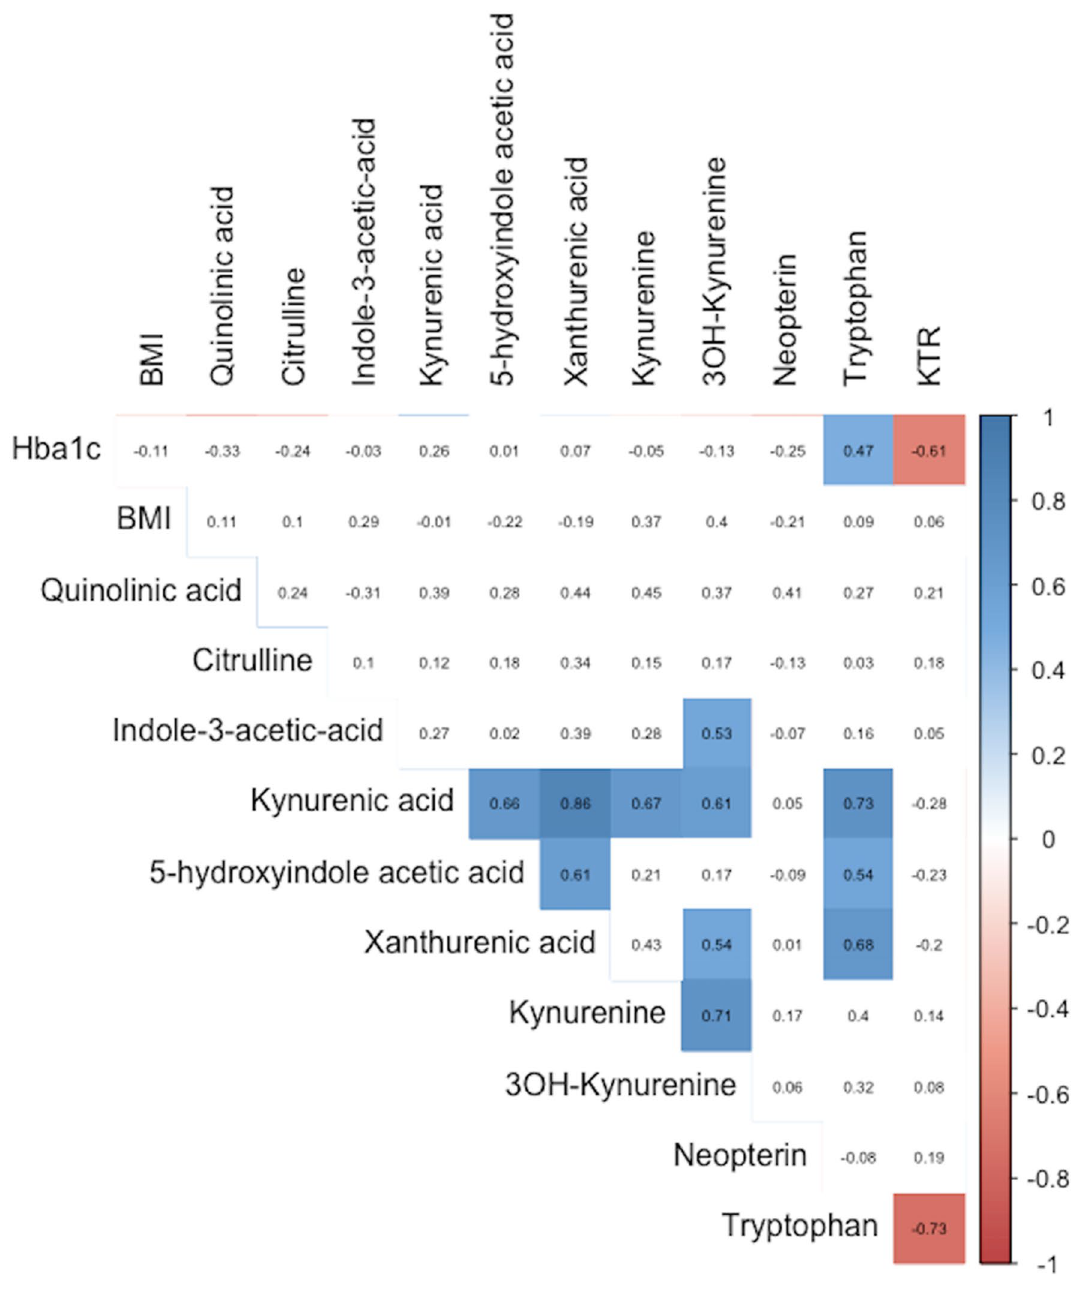
Figure 5. Heatmap displaying Spearman’s Rank correlation co-efficient between Δ of measured parameters and pathway metabolites. Coloured squares indicate significant results p value of <